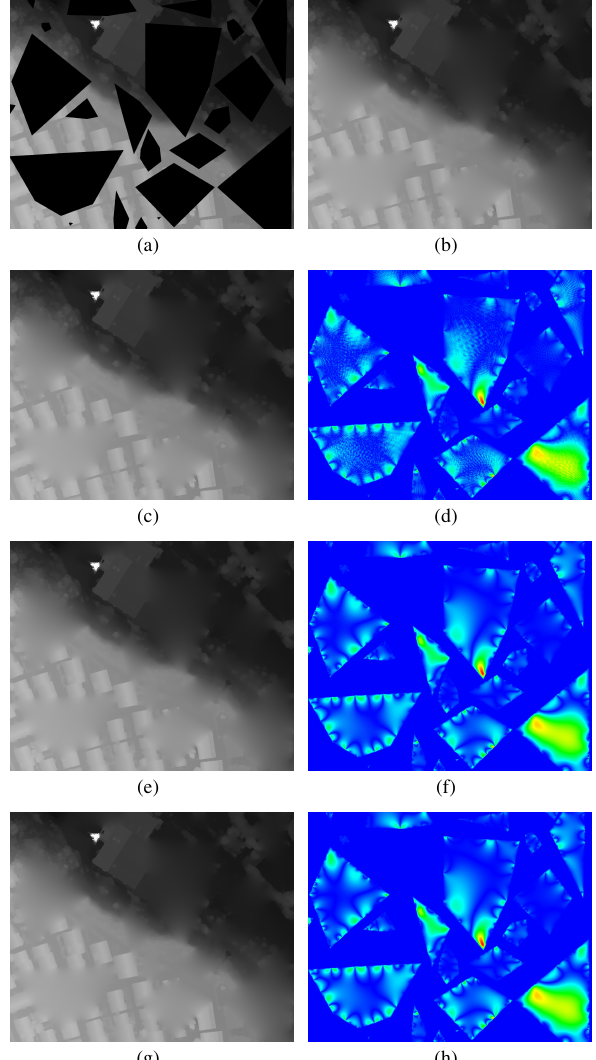
Table 1. Runtime, throughput, mean difference and standard deviation to the reference interpolation for n path orientations for the CPU implementation of the proposed algorithm Figure 6. DSM interpolation details (a) prepared image, 60% valid pixels, (b) reference IDW interpolation, (c) interpolation for n = 64 , (d) heat map for n = 64 , (e) interpolation for n = 256 , (f) heat map for n = 256 , (g) interpolation for n = 1024 , (h) heat map for n = 1024 path orientations most equal distance weights approach zero. The red spots in the heat map are situated near local intensity discontinuities in the DSM. In these areas, the vast number of precise samples in the reference data attenuates the influence of close elevated (bright)